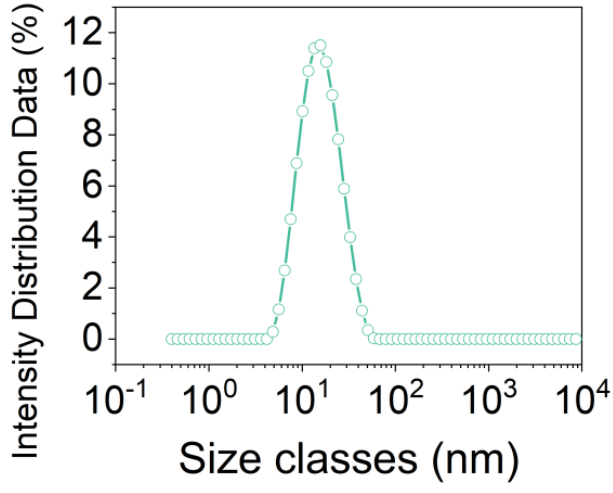
Figure 5. Particle size distribution of the CH formulation.